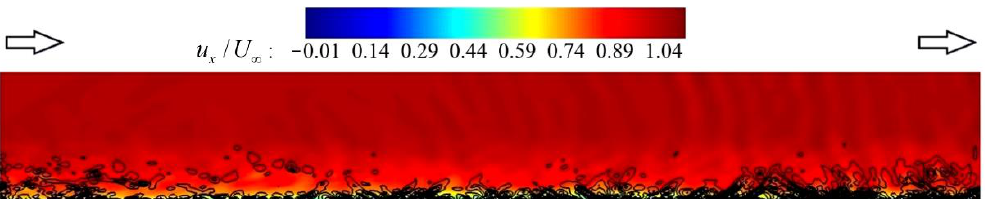
Figure 9. Instantaneous streamwise velocity contours and the second invariant Q contours (black line) of the velocity gradient tensor along the center section in the spanwise direction.